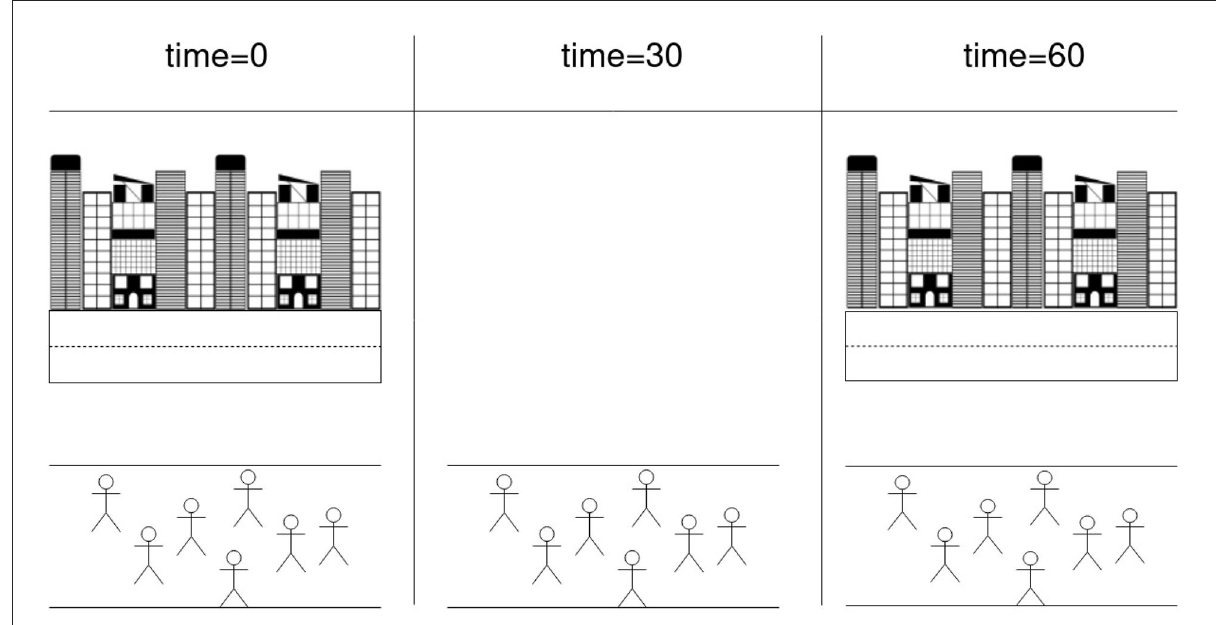
FIGURE5 Simplified representation of the example model in the Russian Dolls pattern rescheduling both models’ execution. The micro-model is processed alone in time=30 as it has a smaller time step than the